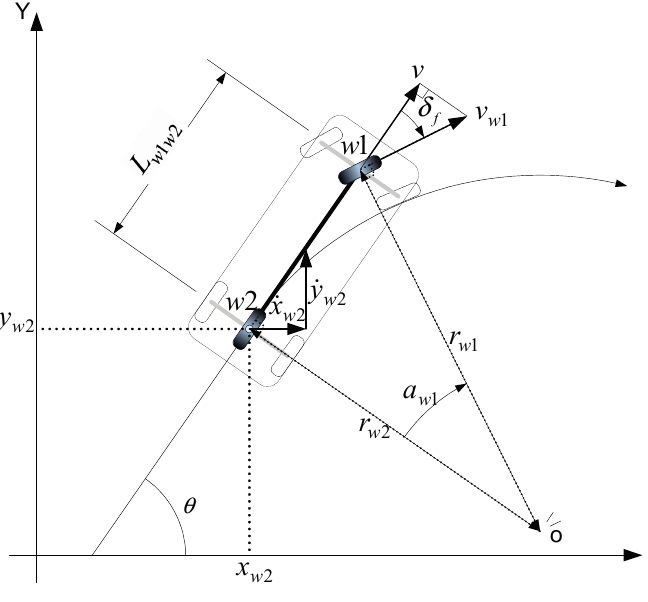
Figure 11. Schematic of vehicle kinematic